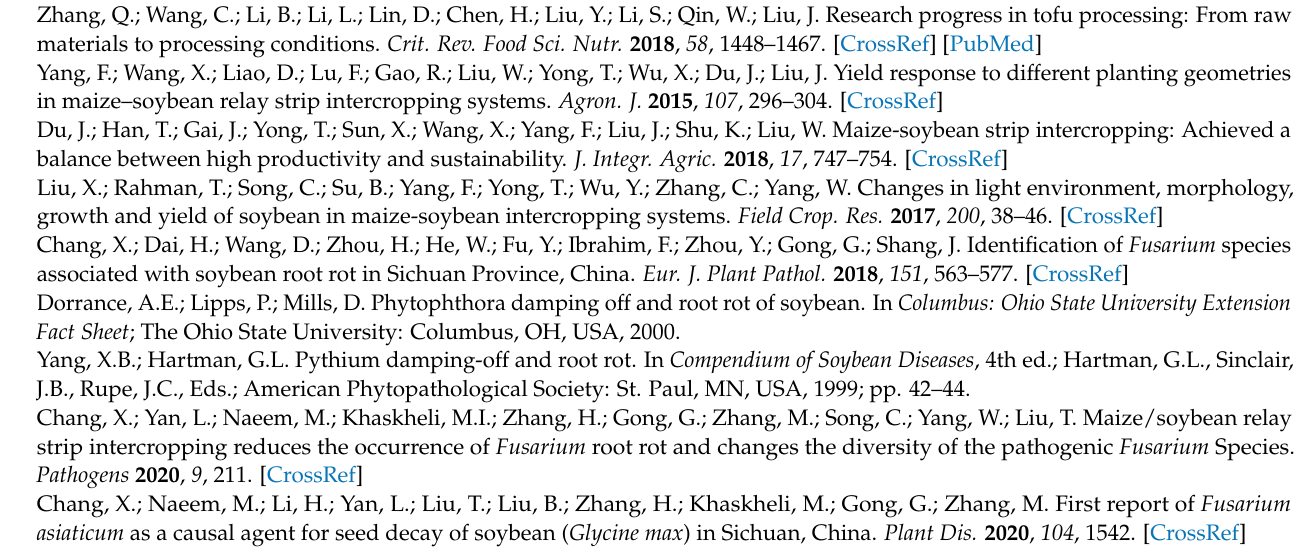
Table S2: Gene ontology (GO) enrichment analysis of Differently expressed genes (DEGs). Table S3: Kyoto Encyclopedia of genes and Genomes (KEGG) enrichment analysis of Differently expressed genes